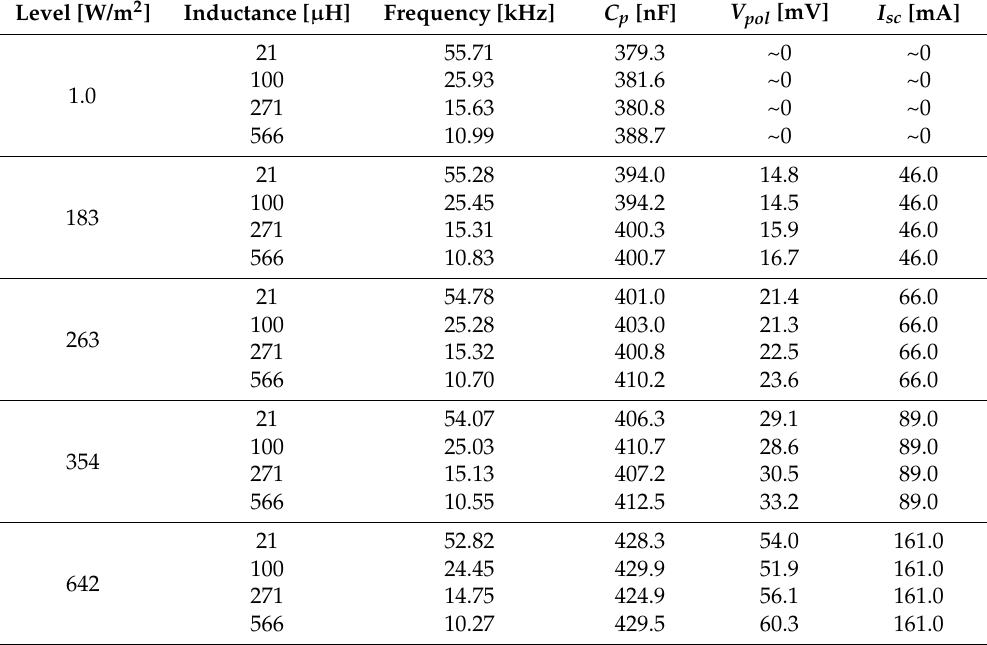
Table 3. The results obtained from